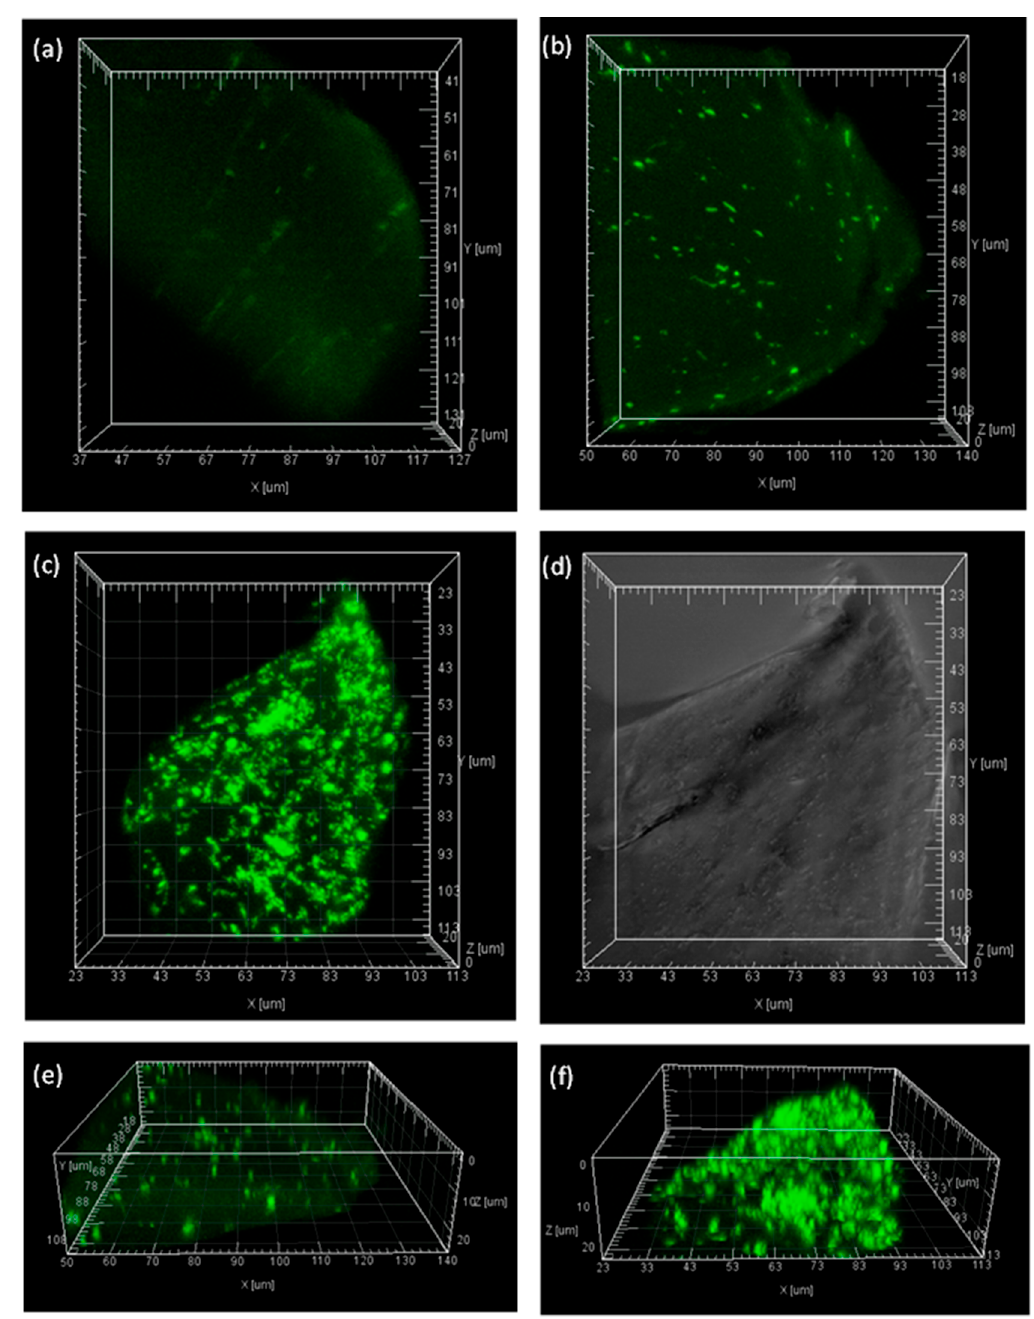
Figure 6. Confocal Laser Scanning Microscopy images of BG distribution inside calcium alginate beads visualized using fluorescein. ( a ) Calcium alginate only; ( b ) and ( e ) IMBG without glutaraldehyde treatment; ( c ) and ( f ) IMBG after 0.75% glutaraldehyde treatment; ( d ) Image of ( c ) but without